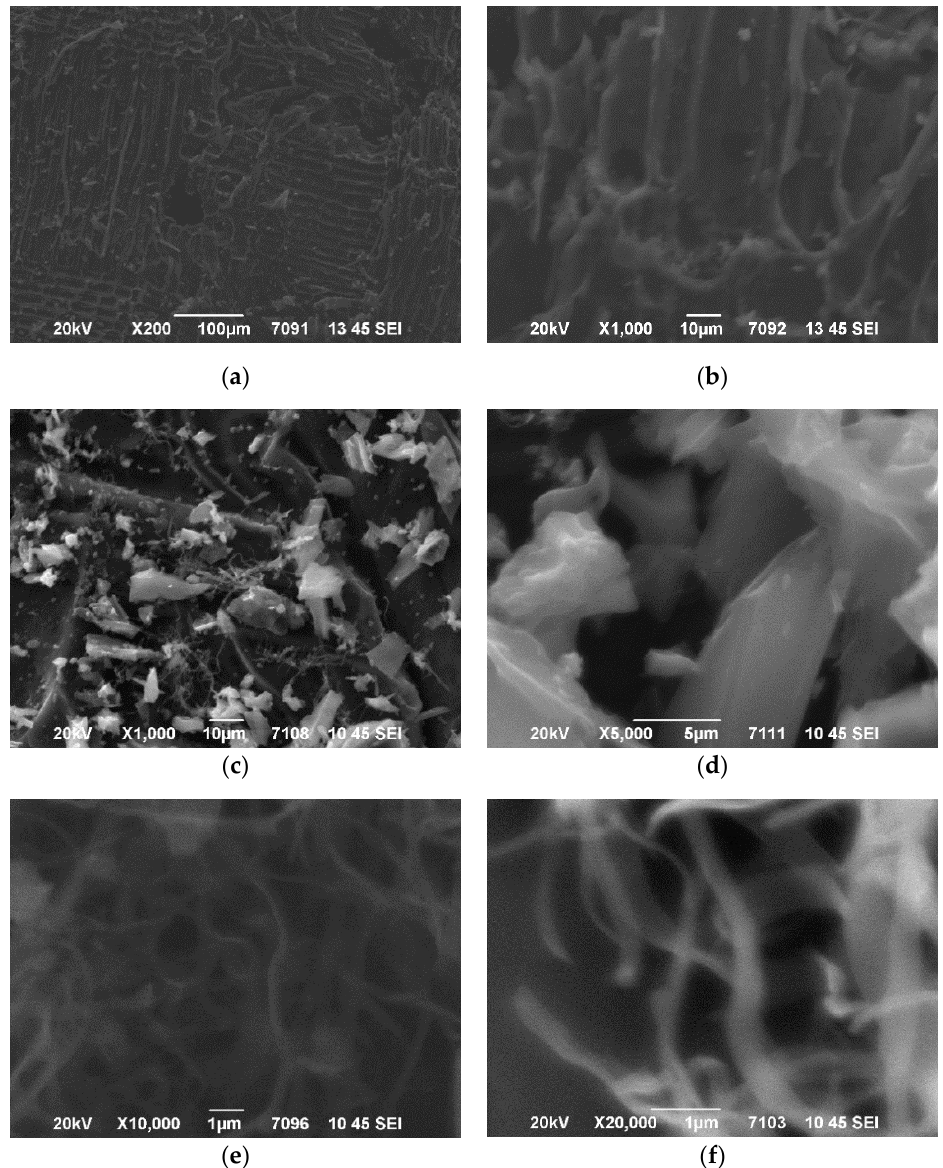
Figure 1. scanning electron microscopy (SEM) images of microstructured charcoal (MC) at a × , ( b ) 1000 × , ( c ) 1000 × , ( d ) 5000 × ( e ) 10,000 × , and ( f ) 20,000 × magnification of ( a ) 100×, ( b ) 1000×, ( c ) 1000×, ( d ) 5000× ( e ) 10,000×, and ( f ) 20,000×. magnification of ( a ) 100